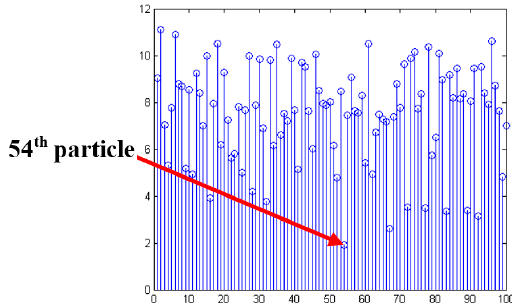
|| || e of the particles. Figure 10. The smallest || e || 1 of the 1